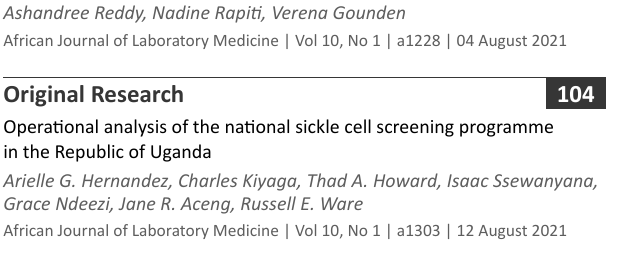
Comparison of 24-hour versus random urine samples for determination and quantification of Bence Jones protein in a South African